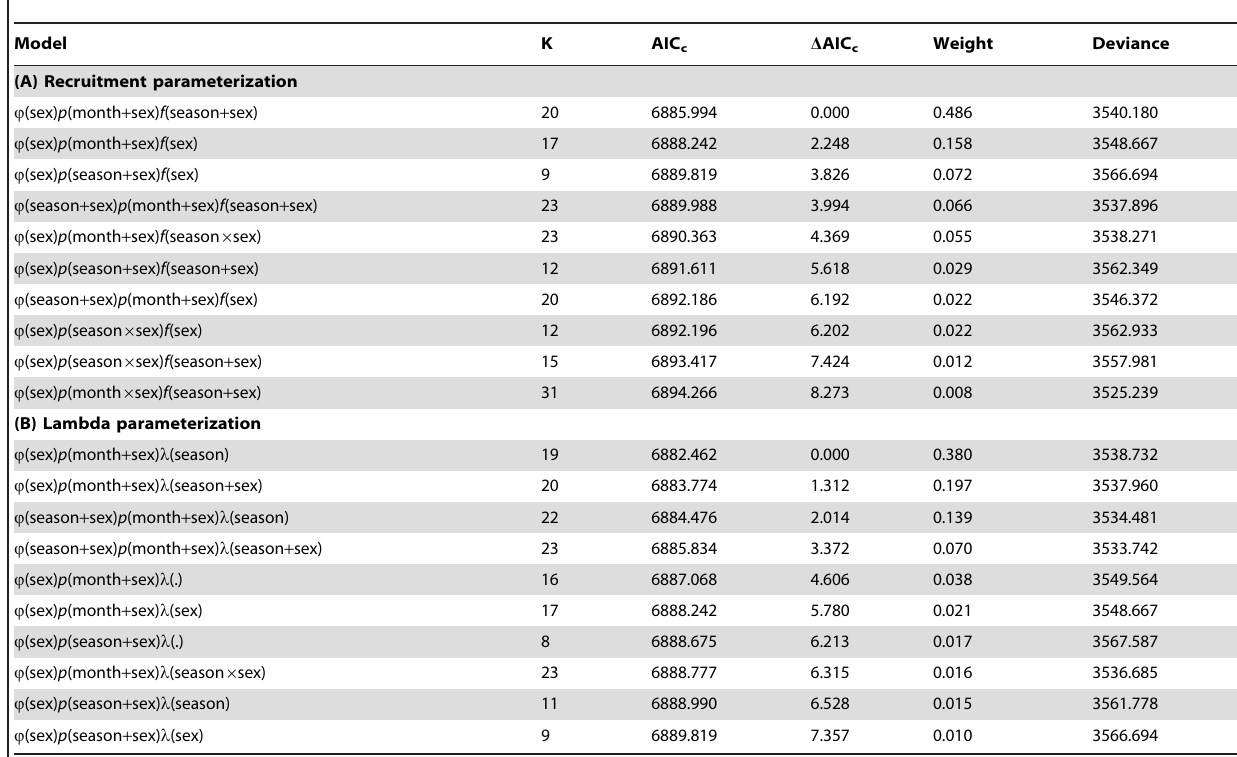
Table 1. Model comparison table for Pradel’s temporal symmetry analysis of data collected from a population of northern raccoons ( Procyon lotor ) at the Ordway-Swisher Biological Station, Florida, from September 1992 to December 1998.